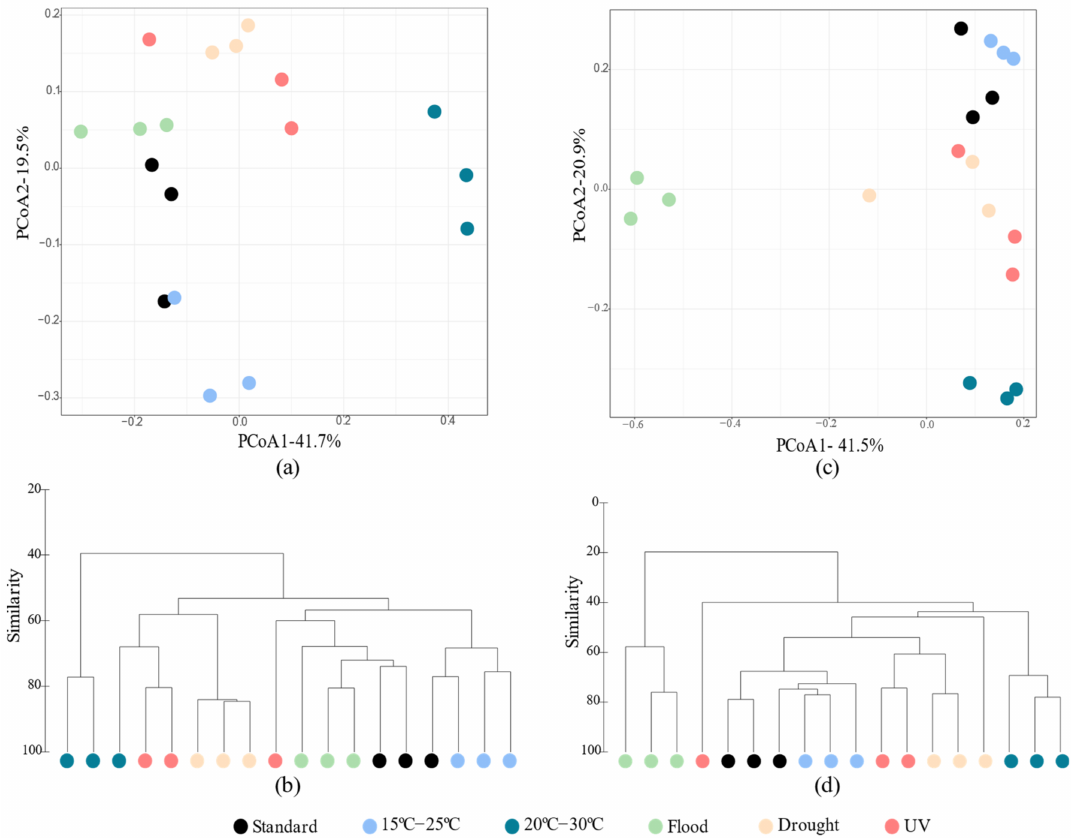
Figure 3. The β diversity measures of Lufa 2.2 soil without ( a , b ) and with ( c , d ) the presence of the soil invertebrate E. crypticus after exposure to each scenario for 48 h. Principal coordinate analyses (PCoAs a , c ) and dendrograms ( b , d ) were based on Bray–Curtis similarity matrices of OTUs abundance tables. Standard refers to the conditions recommended by the standardized OECD guidelines. UV